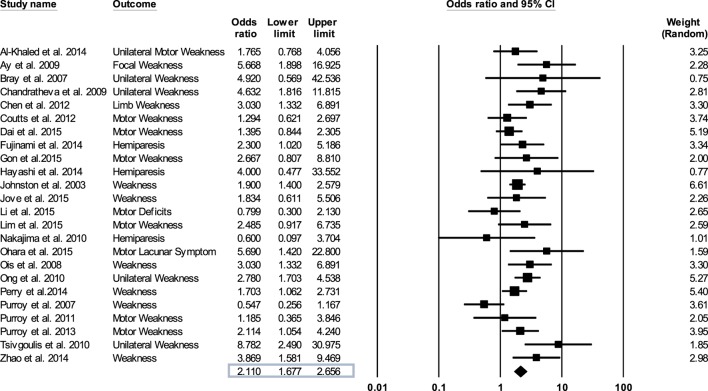
Forest plot derived from a random effects model. Each tick mark and line represents an individual odds ratio with a 95% confidence interval. The diamond shape at the bottom of the forest plot is the overall odds ratio (2.11) for all 24 studies.